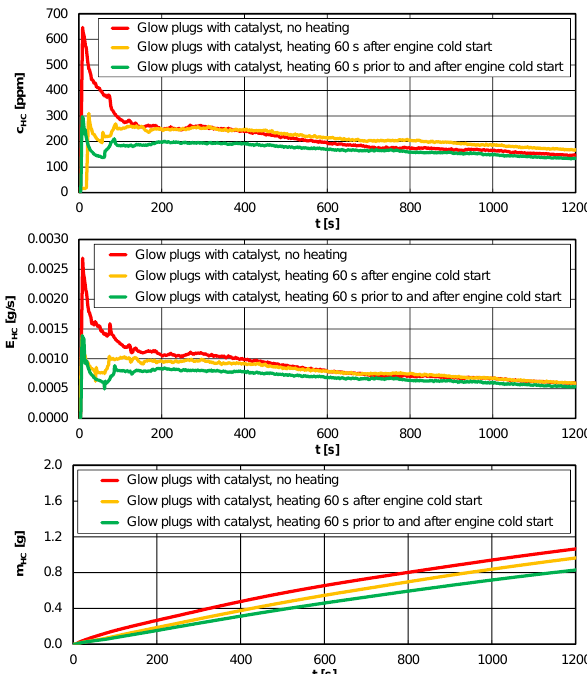
Fig. 3. Concentration, intensity of emission and emission of hydrocarbons during the tests performed on a diesel engine depending on the catalyst- coated glow plug heating time